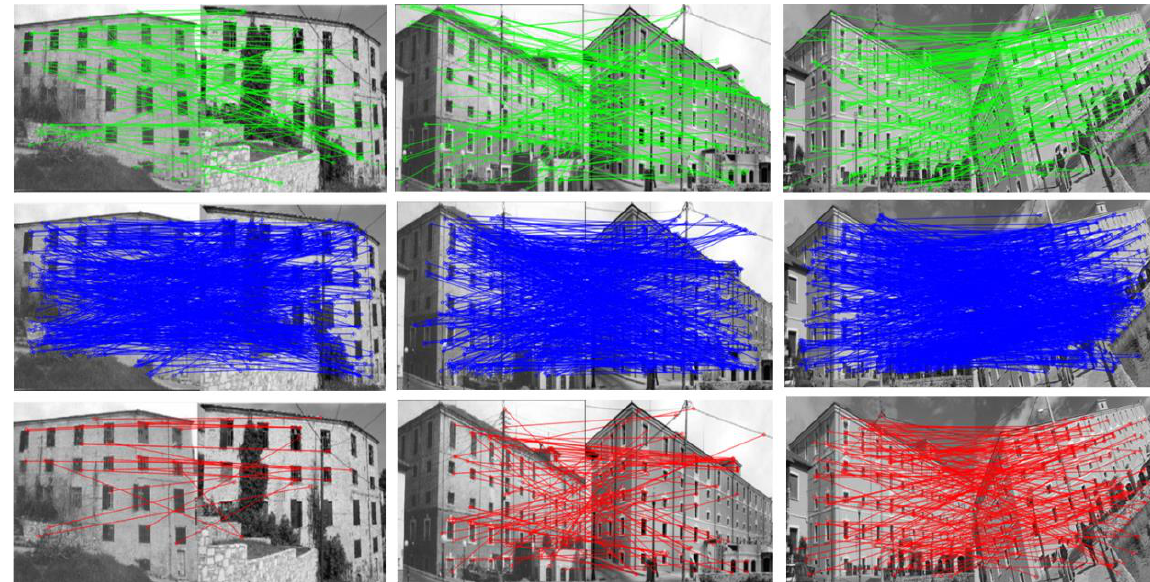
Figure 14. Feature matching. The first column is a pair of historic buildings, the second includes modern and historic buildings, while the third column includes two modern buildings by SIFT (green), ORB (blue), and BRISK (red) by trial-and-error-modified parameters.